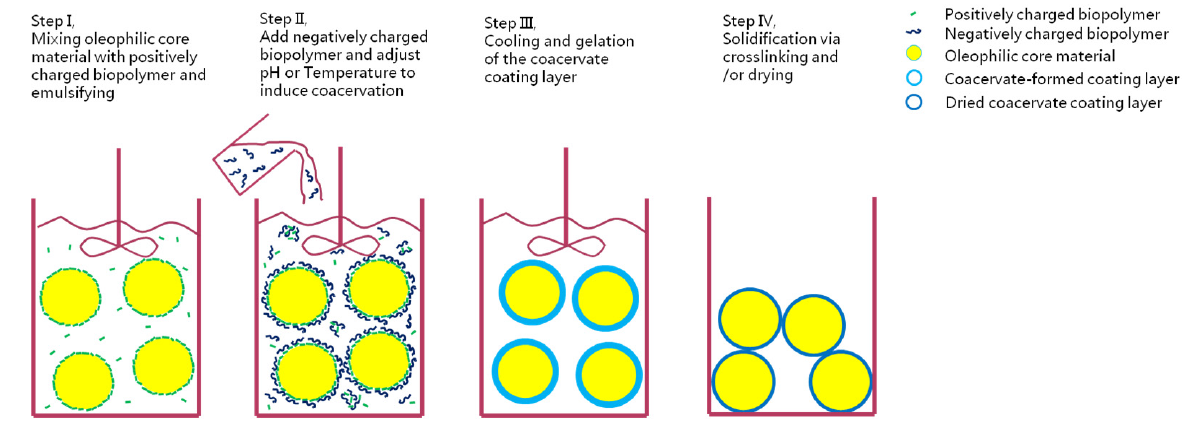
Figure 3. The process of complex coacervation .